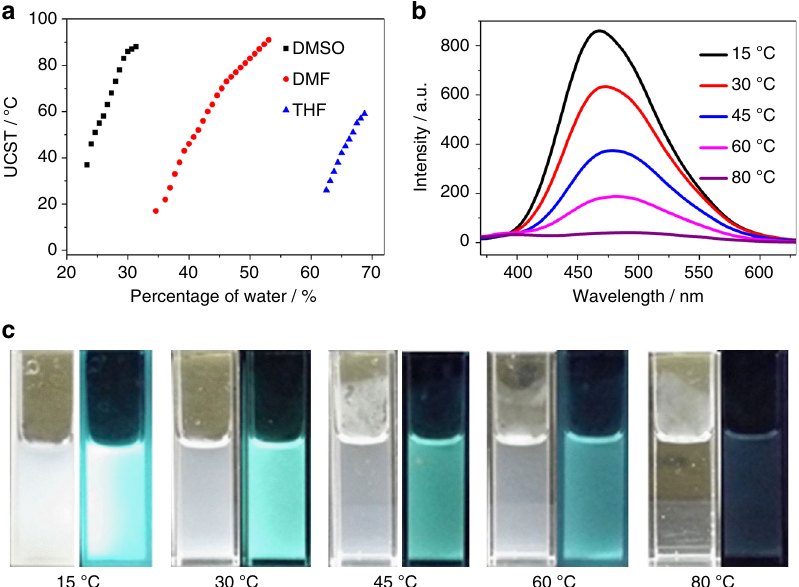
Fig. 4 Dual ( fl uorescent and thermo-) responsive properties of PTPM-1. a Tunable UCST values of PTPM-1 (2 mg/mL) in DMSO, DMF, and THF with different amounts of water (vol%); b emission spectra (excited @346 nm) and c digital photos (under sunlight and irradiation with UV lamp @365 nm, respectively) of PTPM-1 (2 mg/mL) in DMF with 45% of water (vol%) at different temperatures